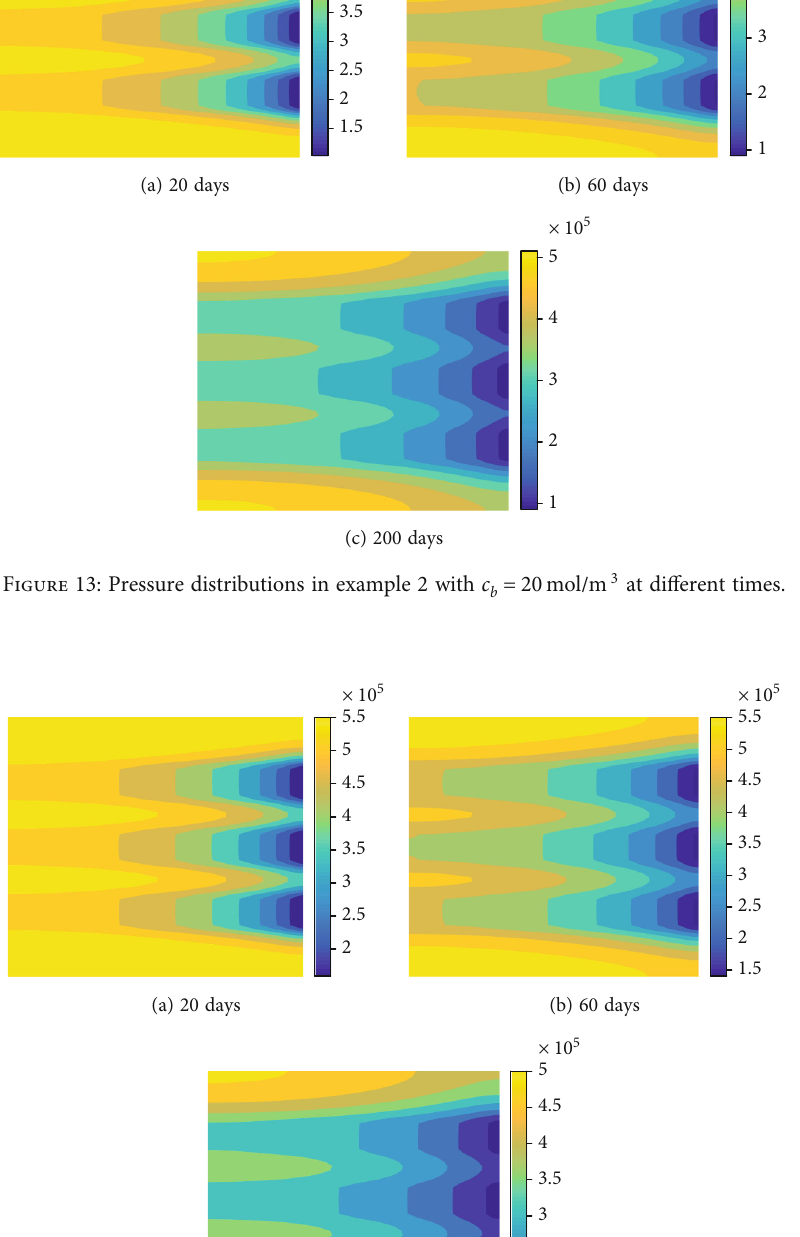
Figure 14: Pressure distributions in example 2 with c